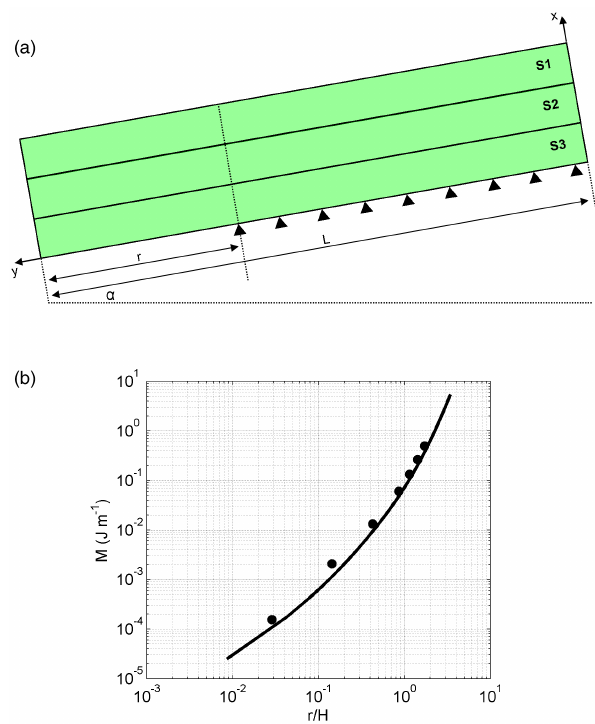
Figure 6. (a) The FE model to calculate the equivalent effec- tive modulus contains as many slab layers as necessary to reflect the stratigraphy found in the SMP signal. Triangles indicate fixed nodes. The beam of length L is overhanging a crack of length r and is inclined by the slope angle α . (b) Mechanical energy M over the ratio of crack length and slab thickness ( r/H ) modeled with FE (dots) and calculated from the analytical solution (line) for a homo- geneous slab with density 200kgm − 3 and a slope angle of 30 ◦